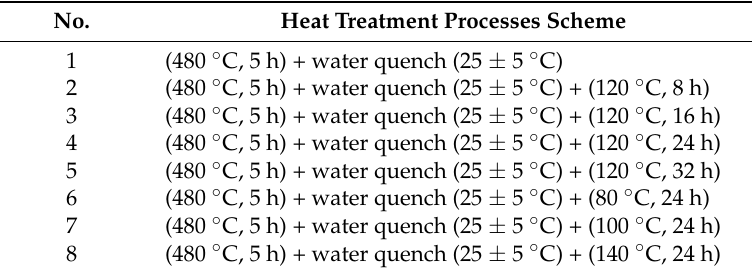
Table 2. The heat treatment processes